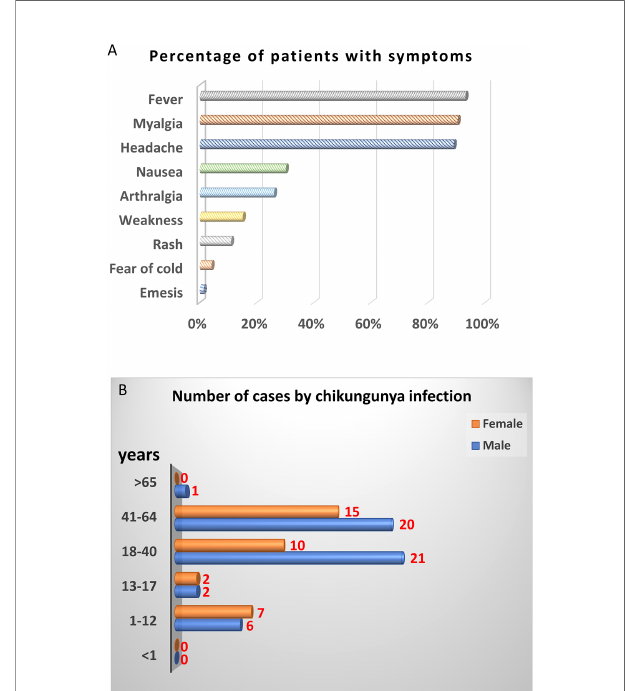
FIGURE 1 | Demographic analysis of CHIKV-positive cases in this study. PCR and sequencing results showed that 88 out of 697 samples were CHIKV-positive. Fourteen CHIKV-positive patients were lack of symptom record. Therefore, only 74 CHIKV-positive patients with symptom record were chosen for demographic analysis. (A) Clinical symptoms. (B) Distribution of age and